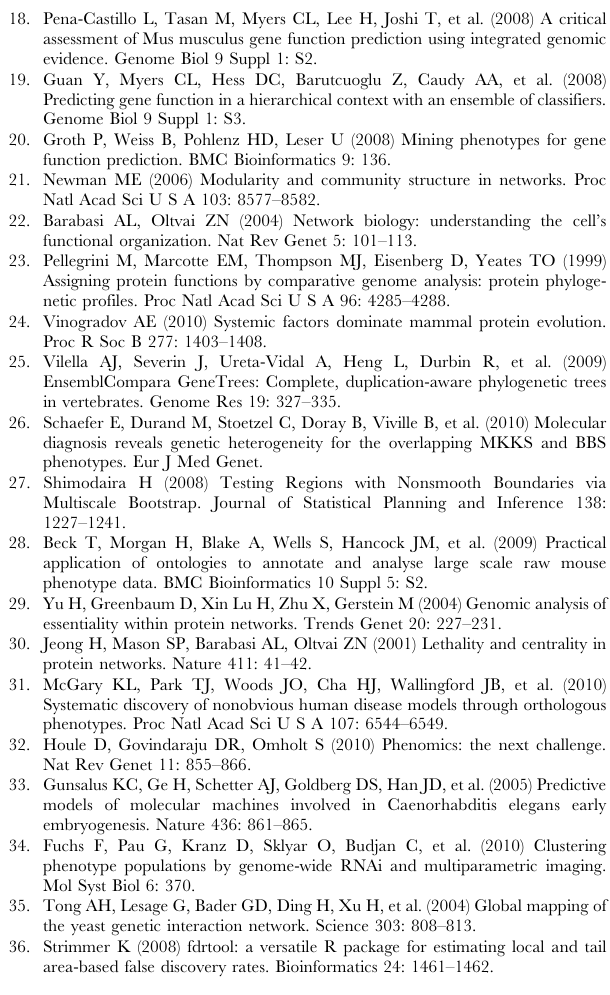
Figure S7 Modularity in the gene and phenotype networks. A)– B) Average clustering coefficient and Newman’s modularity (Q) for randomly re-wired networks (blue) and the corresponding gene network at MP level 5 shown in Fig. 4. d cutoff =0.011. The random networks retain the same degree distribution as the empirical gene network. C)–D) Average clustering coefficient and Newman’s modularity (Q) for randomly re-wired networks (blue) and the corresponding phenotype network at MP level 5 shown in Fig. d cutoff =0.005. (TIFF) Figure S8 Phylogenetic profile correlation in communities. Shown are probability densities for genes within communities (red) compared to a random control (black) for the gene networks presented in the text at level 5 (A) and 8 (B). (TIFF) Text S1 Edge list for the gene network at MP level 5 and with d cutoff = 0.009. (TXT) Text S2 Edge list for the phenotype network at MP level 5 and with d cutoff =0.005. (TXT) Table S1 Top level MP terms that can form discrete communities, form communities which fall below the